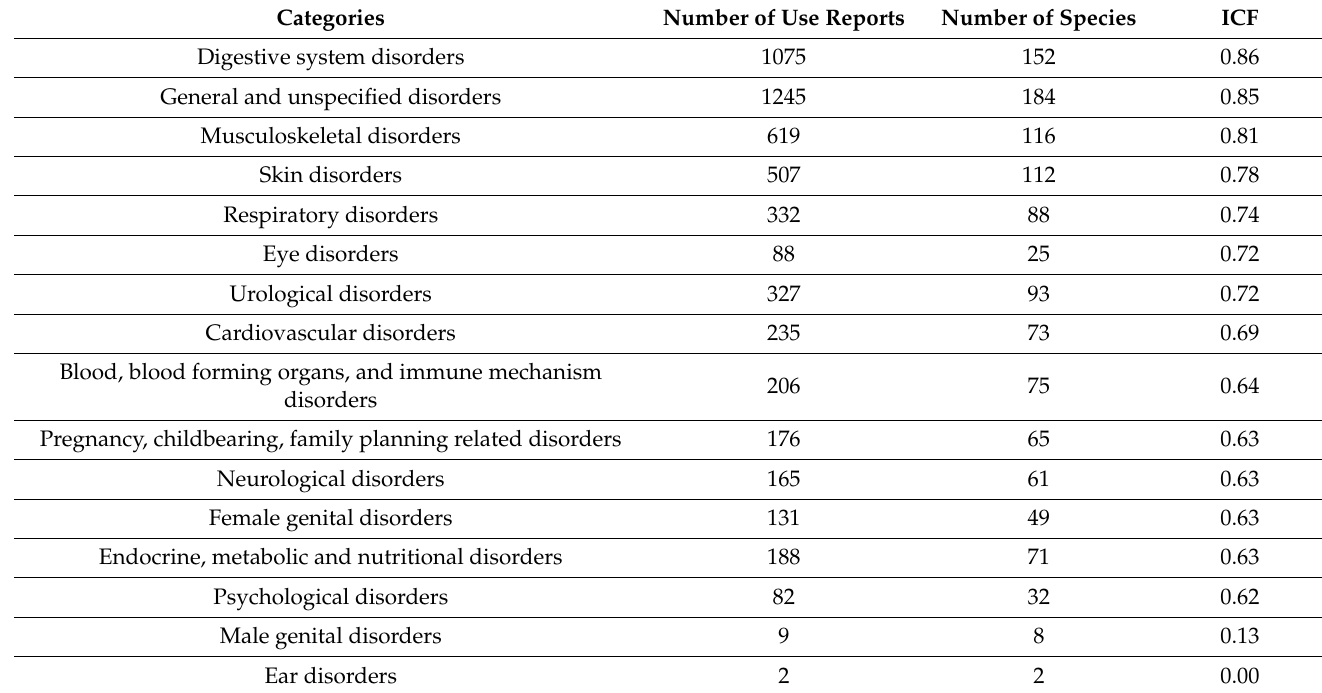
Table 2. Informant consensus factor (ICF) for categories of disorders treated by legumes, as reported in 152 studies of traditional medicine in Thailand published from 1986–2019.